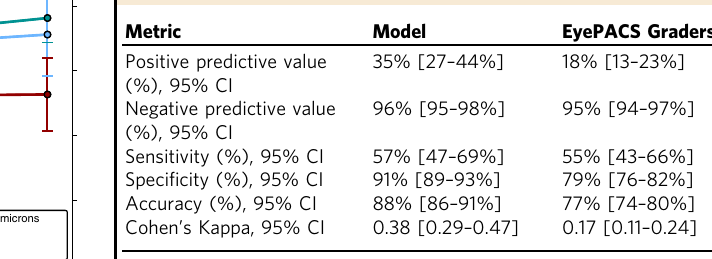
Fig. 4 Receiver operating characteristic curve of the model compared with eyepacs graders. The graders ’ grades for predicting ci-DME on the secondary clinical validation set are shown as a red dots. All methods (i.e., the model and eyepacs graders) rendered their grades using monoscopic fundus images only. The ground truth for ci-DME was derived using OCT (central sub fi eld thickness ≥ 300 μ m). Table 3 Performance metrics of the model and eyepacs graders on the secondary clinical validation